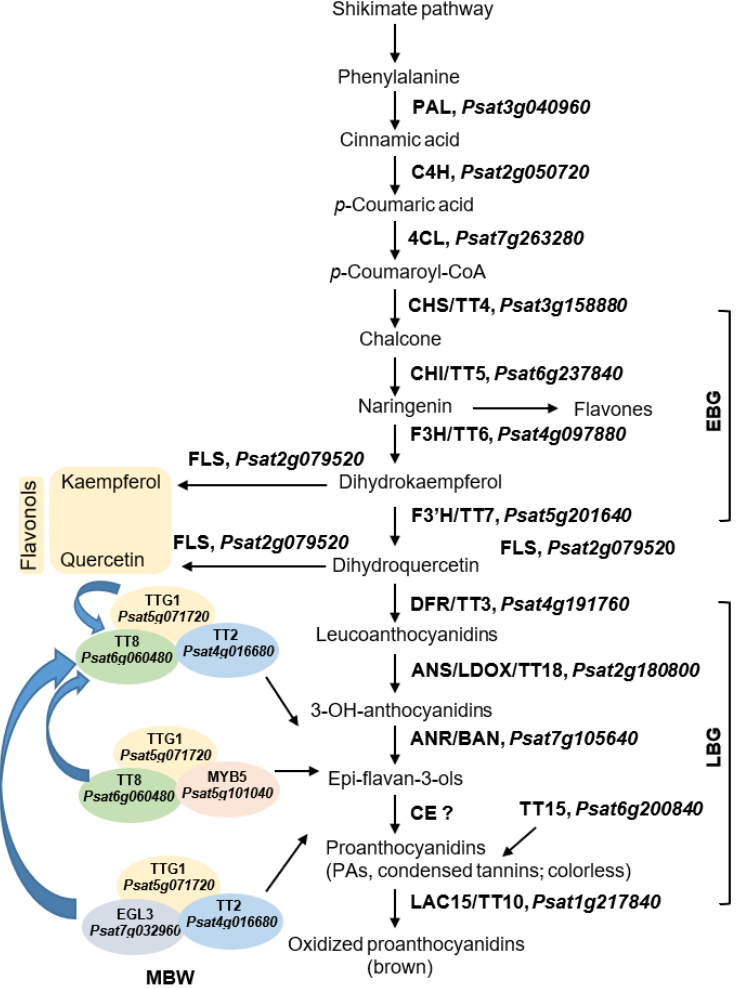
Figure 2. Scheme of putative tannin biosynthesis pathway in Pisum sativum L. seed coat. Flavonoid pathway was adapted from several references [73–75]. The gene ID was obtained using blastp against the pea reference genome sequence database ( Pisum sativum L. version 1a) (https://urgi.ver-